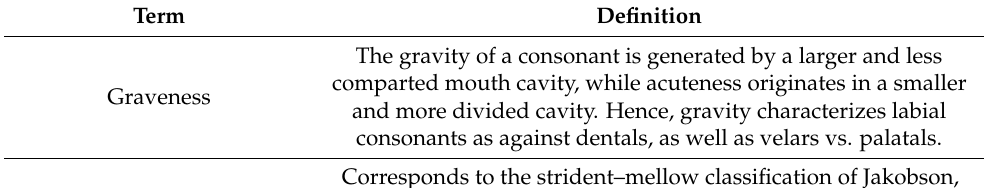
Table A3. Cont. Term Definition The gravity of a consonant is generated by a larger and less comparted mouth cavity, while acuteness originates in a smaller Graveness and more divided cavity. Hence, gravity characterizes labial consonants as against dentals, as well as velars vs. palatals. Corresponds to the strident–mellow classification of Jakobson, Fant, and Halle (1952). Sibilant consonants are primarily Sibilation characterized by a noise, which is due to turbulence at the point of articulation. Corresponds to the continuant vs interrupted classification of Jakobson, Fant, and Halle (1952). Classifies consonants into Sustention clearly continuous consonants and other transient phones, such as plosives. The oral (or more exactly, the non-nasalized) phonemes are formed by the air stream, which escapes from the larynx through the mouth cavity only. The nasal (or more exactly, nasalized) Nasality resonator is supplemented by the nasal cavity.